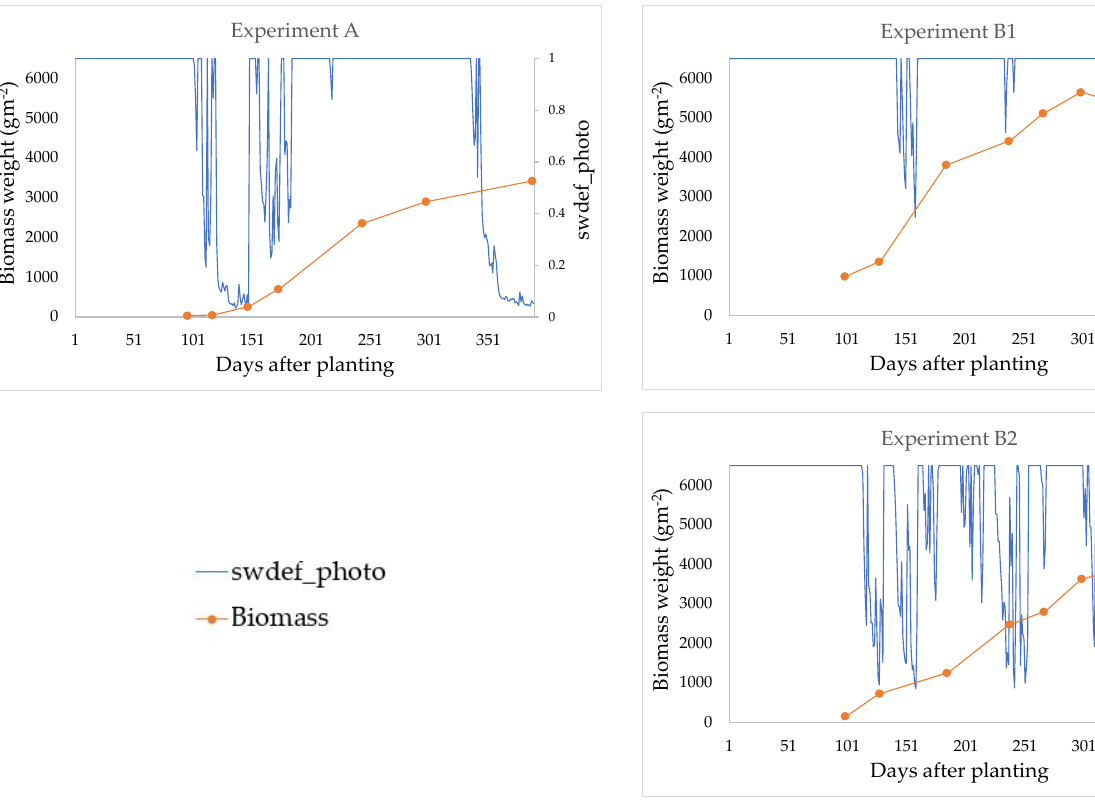
Figure 9. Observed biomass weight (g m − 2 ), APSIM-simulated soil water deficit factor (0 = full stress and 1 = no stress) for photosynthesis ( swdef_photo ) and nitrogen deficit factor (0 = full stress and 1 = no stress) for photosynthesis ( nfact_photo ) of cultivar KK3 in experiments A, B1 and B2 from planting to harvesting.